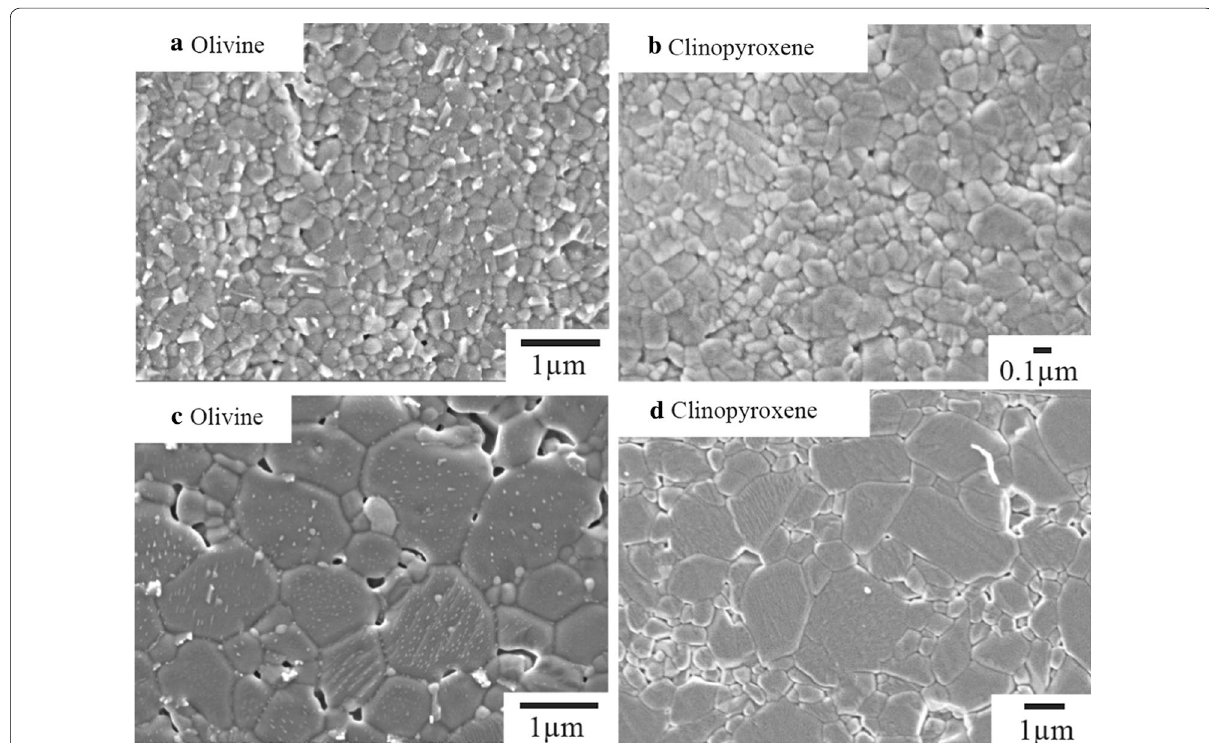
Fig. 1 Scanning electron microscopy (SEM) images of the sintered samples of a , c olivine and b , d clinopyroxene from powders milled with etha- nol. In both samples, polished and thermal-etched cut sections are shown. Each sample was sintered for 2 h at different temperatures of a 1200 °C, b 1130 °C, c 1300 °C, and d 1280 °C. The small bright particles in the SEM images of sintered olivine were identified as magnetite from the thermal- etching processes via energy-dispersive X-ray spectroscopy (EDS) and Raman analysis